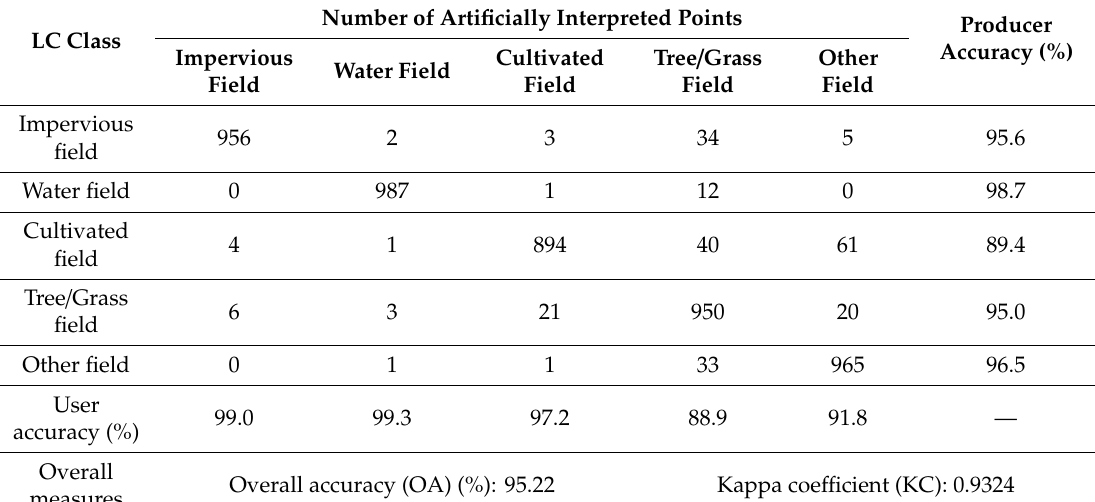
Table 3. Confusion matrix of the LC update using the proposed geo-object-based Auto-LCU